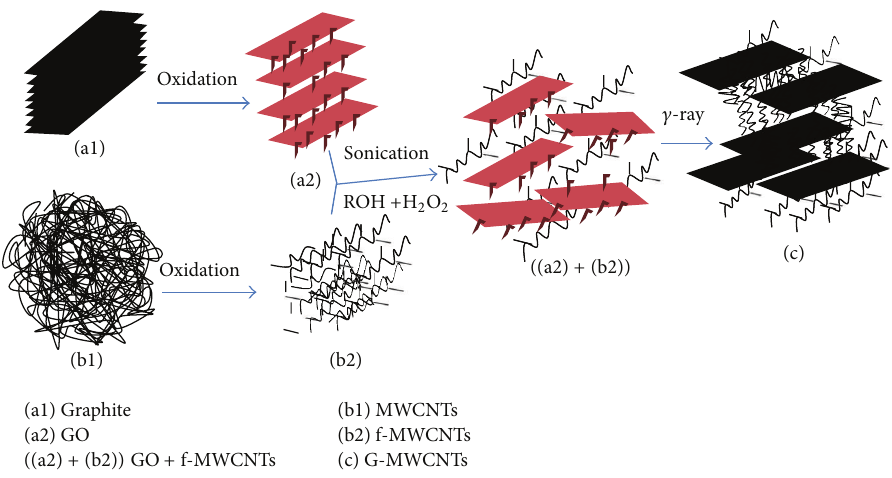
Figure 1: Schematic illustration for preparation of G-MWCNTs